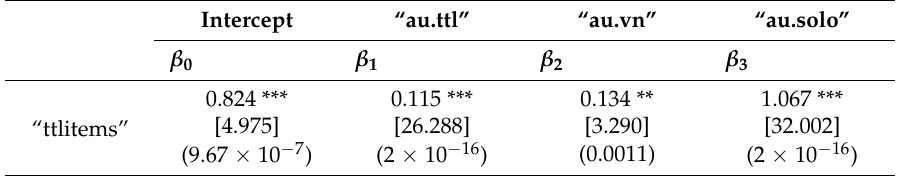
Table 2. Estimation results of “ttlitems” as influenced by “au.ttl”, “au.vn” and “au.solo”. Intercept